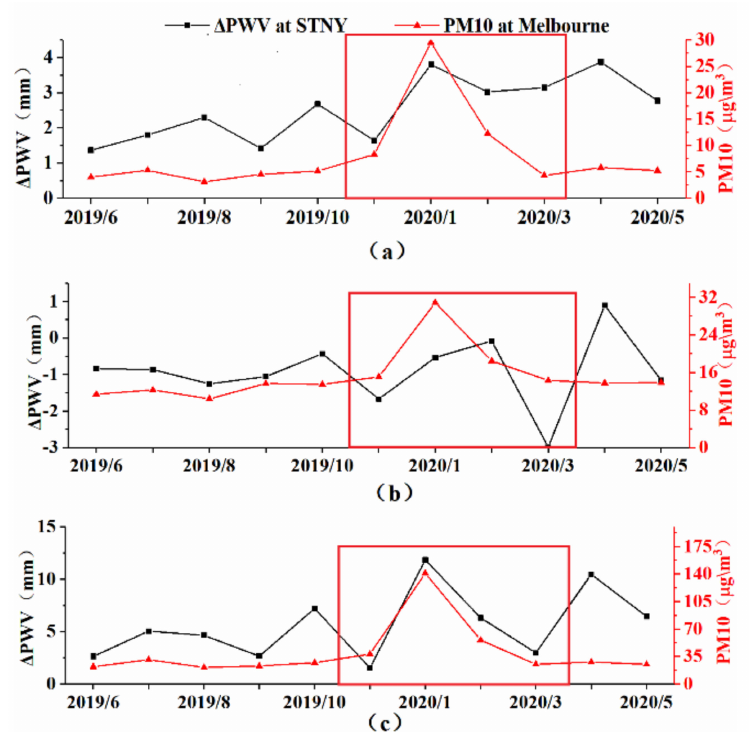
Figure 3. Statistical results of ∆ PWV and PM10 at STNY (( a ) STD statistics, ( b ) MEAN statistics, ( c ) MAX statistics of STNY).